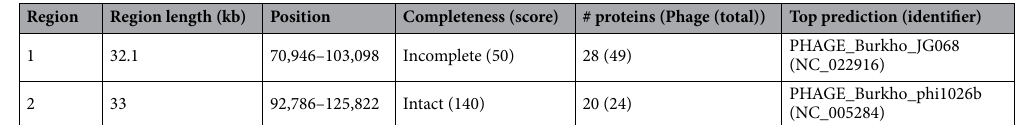
Region Region length (kb)